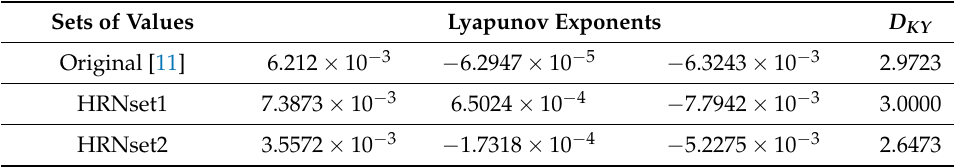
Figure 7. Chaotic time series generated by using the sets of values listed in Table 4: ( a ) original, ( b ) HRNset1, and ( c ) HRNset2, plotting the state variable x . Table 5. Lyapunov exponents and Kaplan–Yorke dimension D KY associated to each set of values from Table